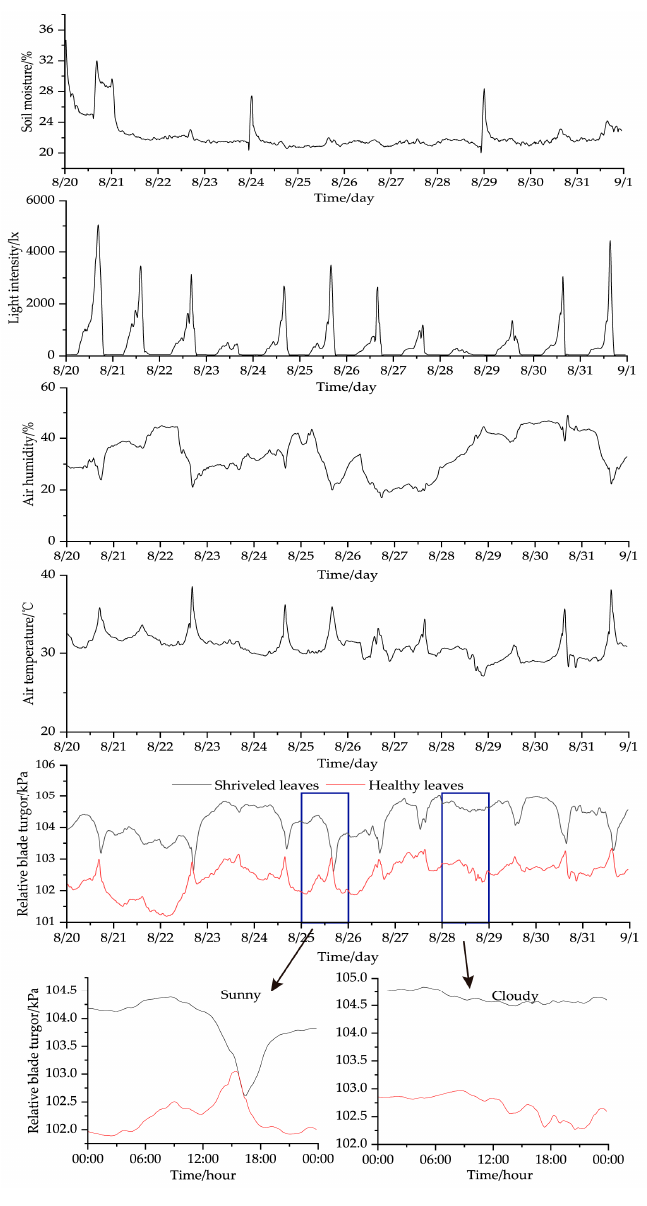
Figure 14. Changes in relative leaf turgor pressure under long-term monitoring and different weather conditions. The relative expansion pressure in different weather varied, with the relative leaf ex- pansion pressure in sunny weather increasing by 6.7% compared to the minimum value in 1 day, while in rainy weather, it only increased by 3%. This means that the value of the leaf expansion pressure changes little under rainy weather. This is partly due to the fact